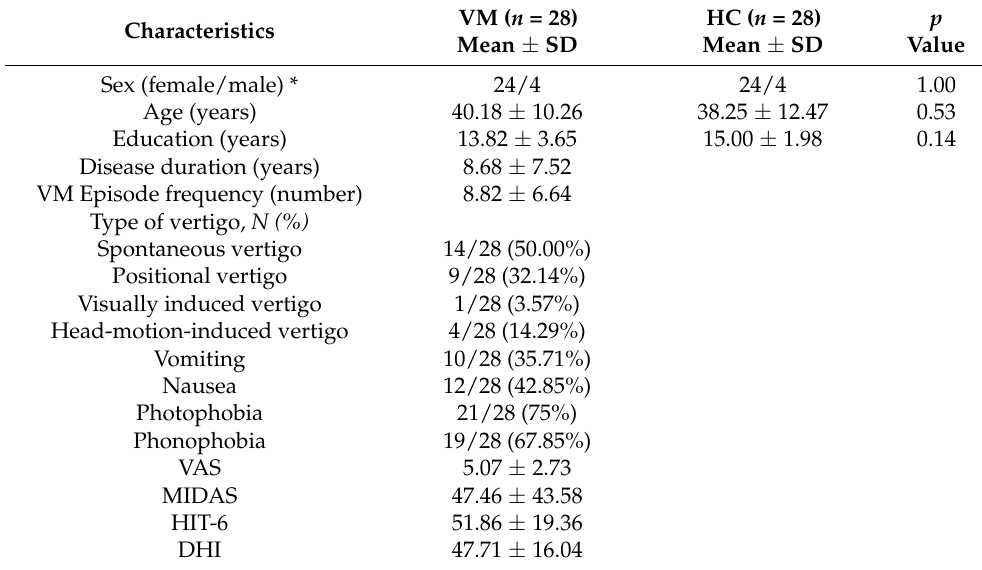
Table 1. Demographic and clinical characteristics.